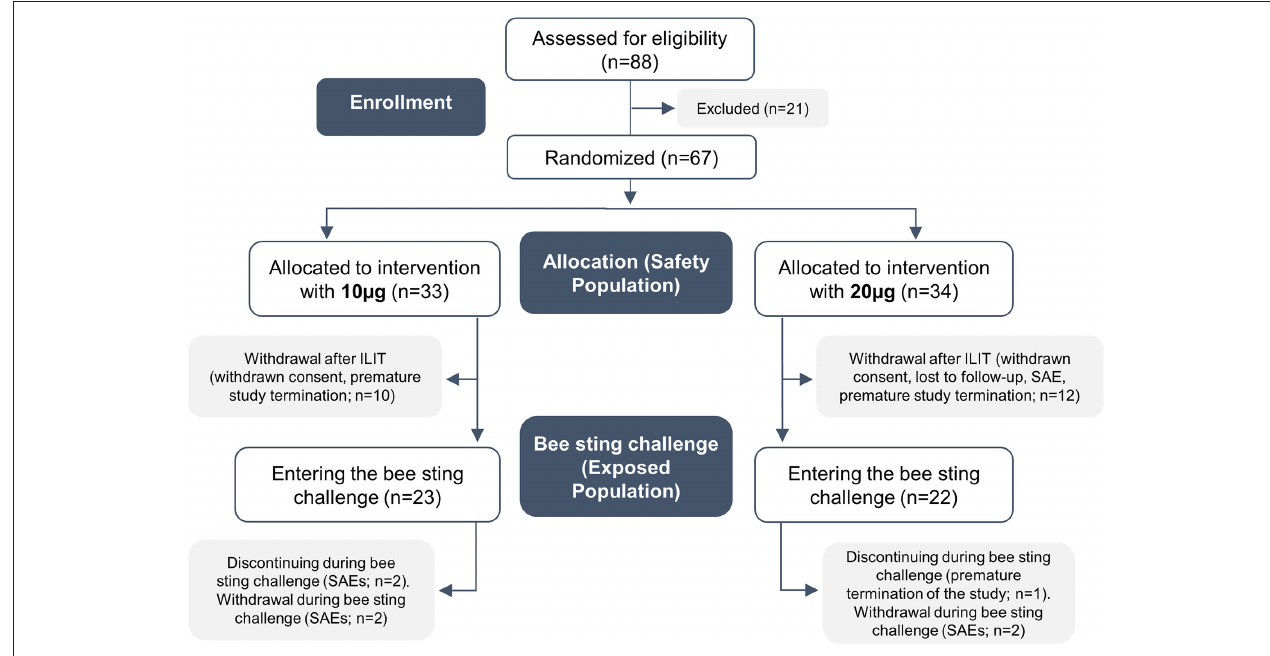
FIGURE 3 | Flow chart illustrating the development of cohorts and patients in this